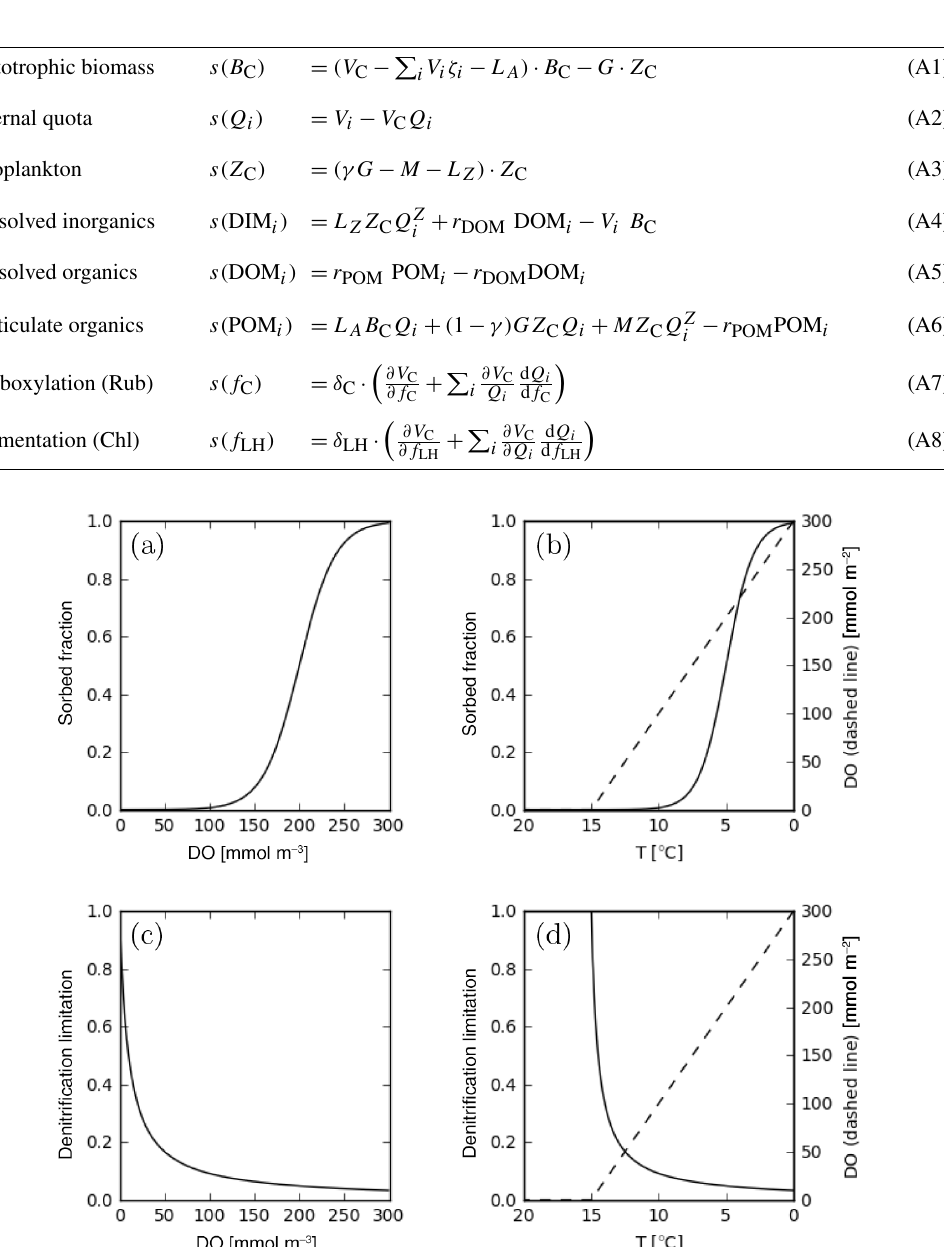
Figure A1. Fraction of sorbed fraction of benthic phosphorus as a function of DO (a) and T (b) , regulation of benthic denitrification rate as functions of DO (c) and T (d) , and DO as a function of T (b, d)